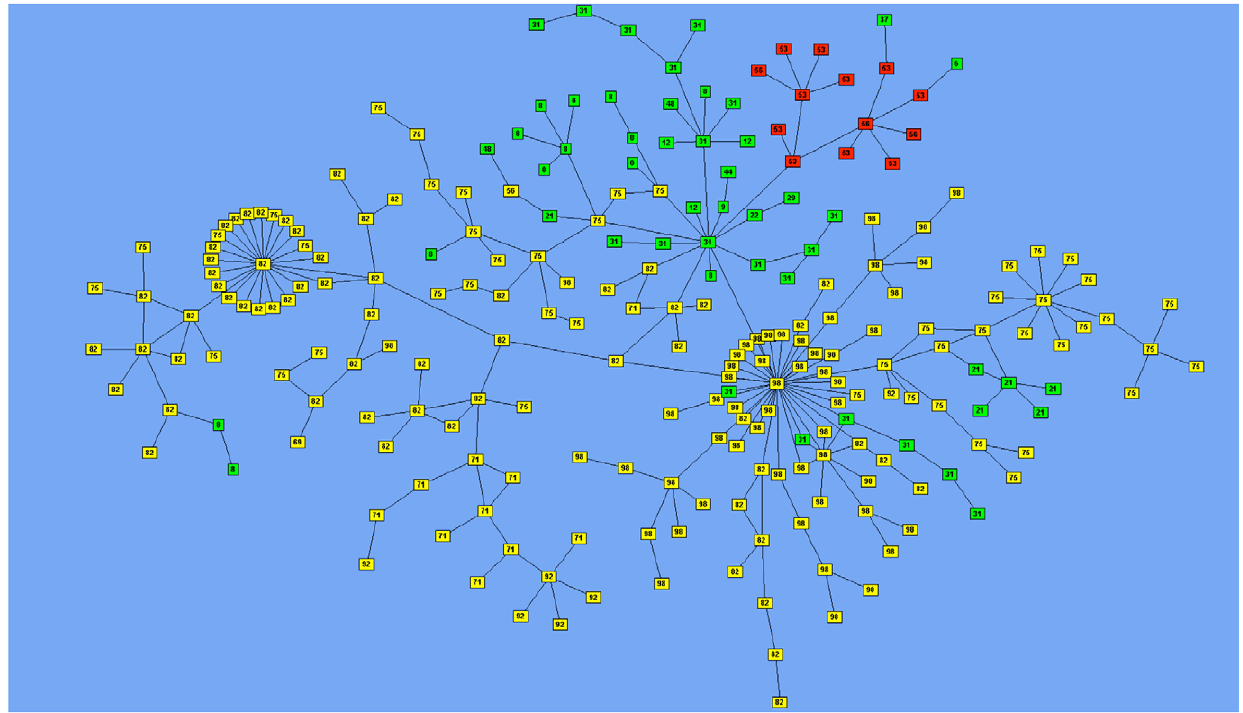
Figure 4. Network structure of the largest observed CTS Chain. This is the network structure of the largest CTS Chain consisting of 242 holdings. Each box represents a distinct holding, and links between boxes represent CTS Links. Boxes coloured Red, Green, and Yellow are holdings located in Wales, England, and Scotland respectively. Boxes are labelled with their holding’s county number.